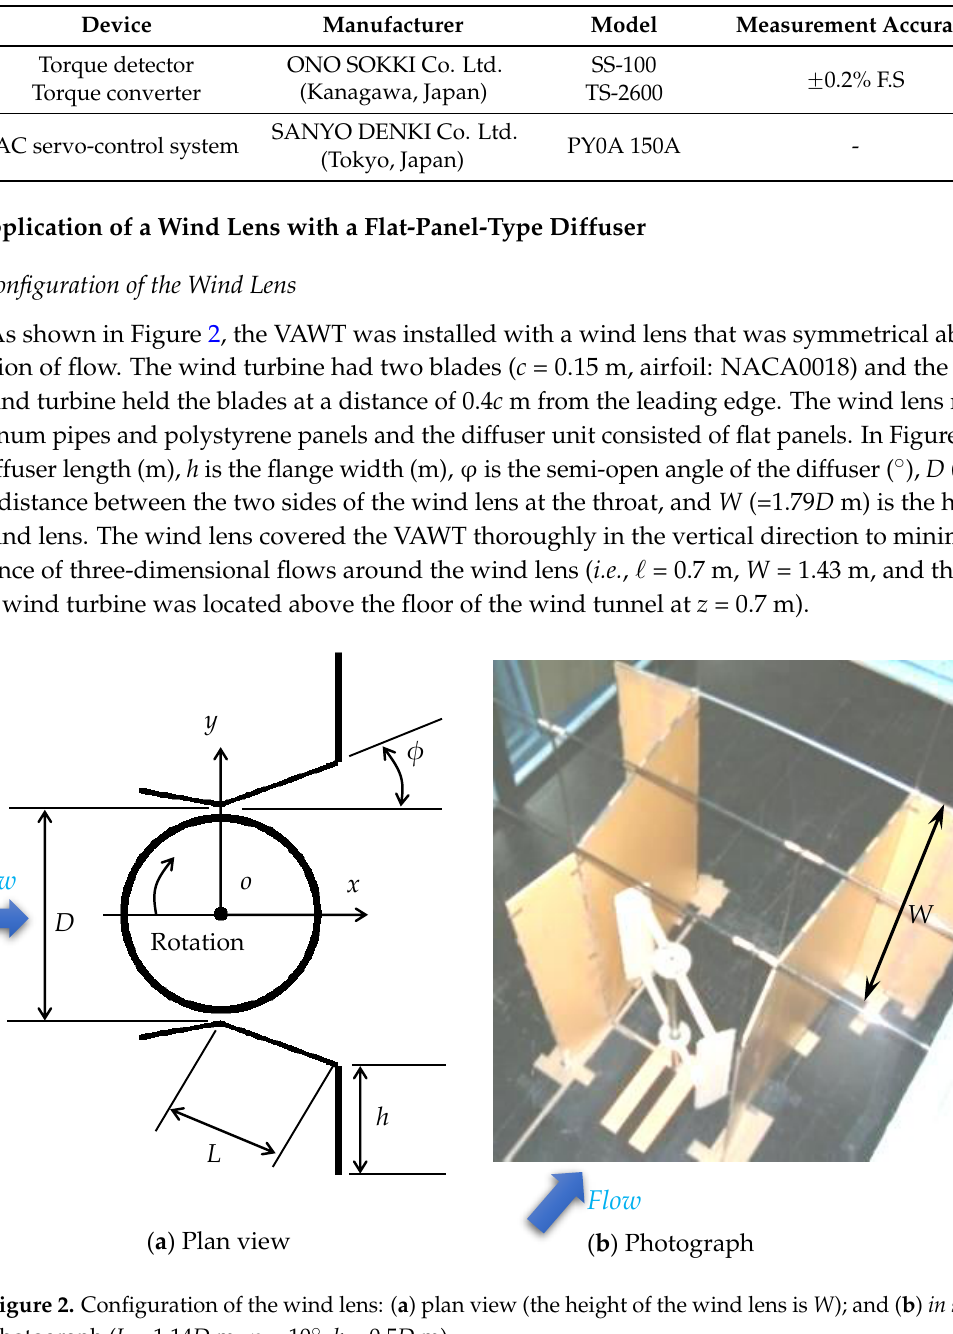
Table 1. Torque transducer and AC servo-control system.